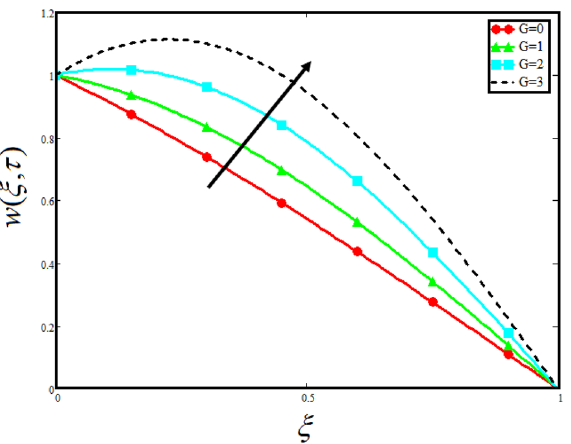
Figure 13. Variation in velocity of nanofluid against different values of G when τ = 1 , φ hnf = 0.02 , Pr = 21 , Gr = 4 , α = 0.5 , (cid:31) = 3 , β = 1.2 and Re = 1.2 .